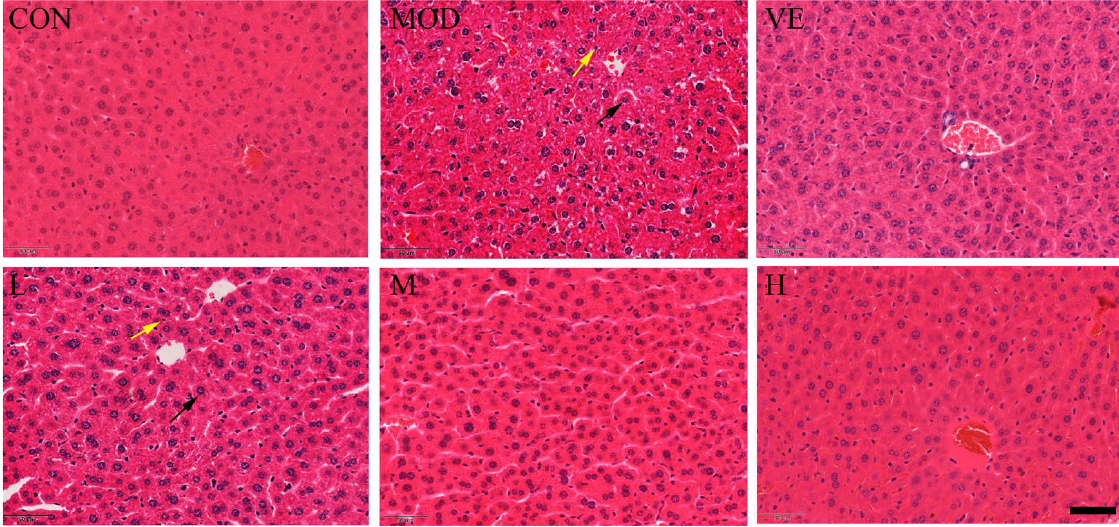
Figure 1. Effect of osthole on liver histology in D-Gal-injected mice, revealed by hematoxylin–eosin (HE) staining. CON, control group; MOD, model group; VE, positive group; L, D-Gal + 100 mg/kg osthole; M, D-Gal + 200 mg/kg osthole; H, D-Gal + 400 mg/kg osthole. Yellow and black arrows indicate inflammatory cells and enlarged hepatocytes, respectively. Scale bar: 50 µm and magnification power × 1000.